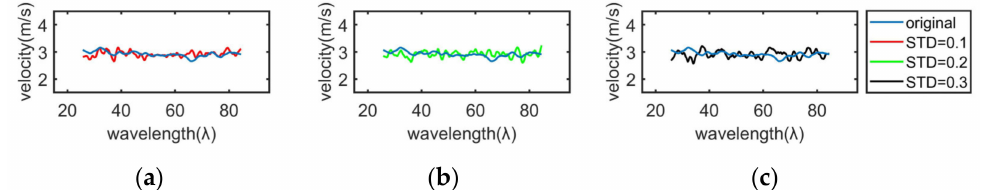
Figure 10. Shear wave velocity estimation with different standard deviation noise. The standard deviation is ( a ) 0.1, ( b ) 0.2, ( c ) 0.3.